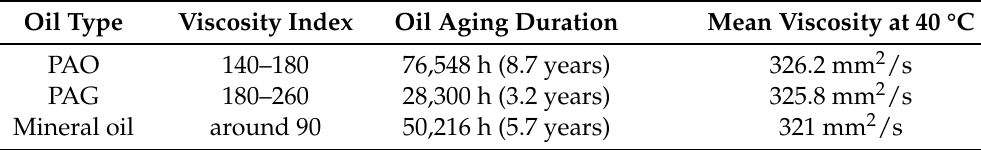
Table 1. Lubrication properties of some oil base stocks of gearbox oils [29].